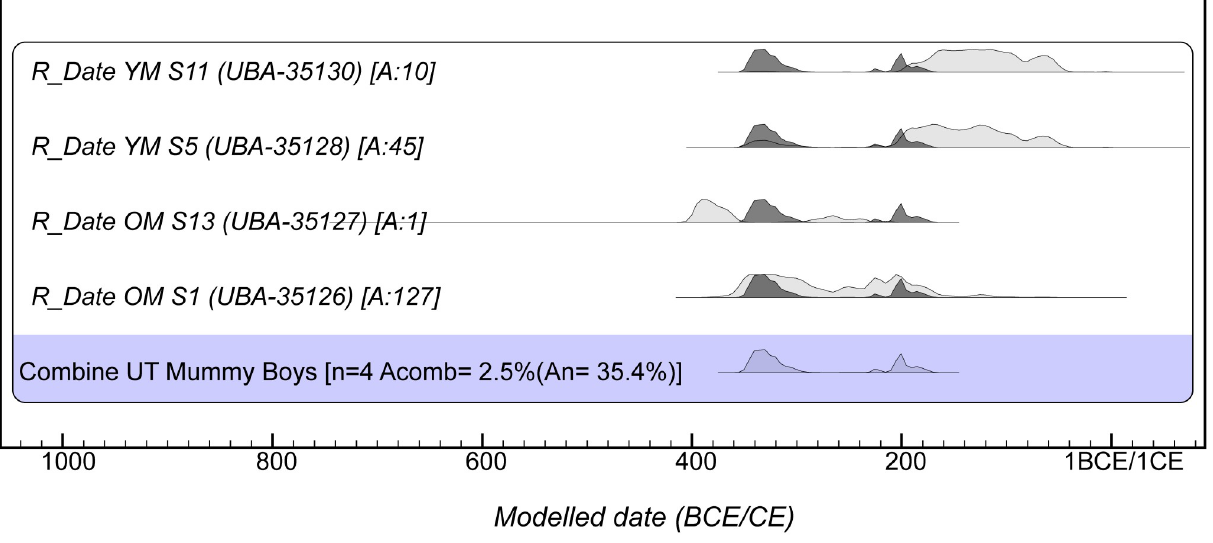
Fig 2. The calibrated dates of the two mummies and the OxCal4.3.2 combine model shows that the subjects were not buried at the same